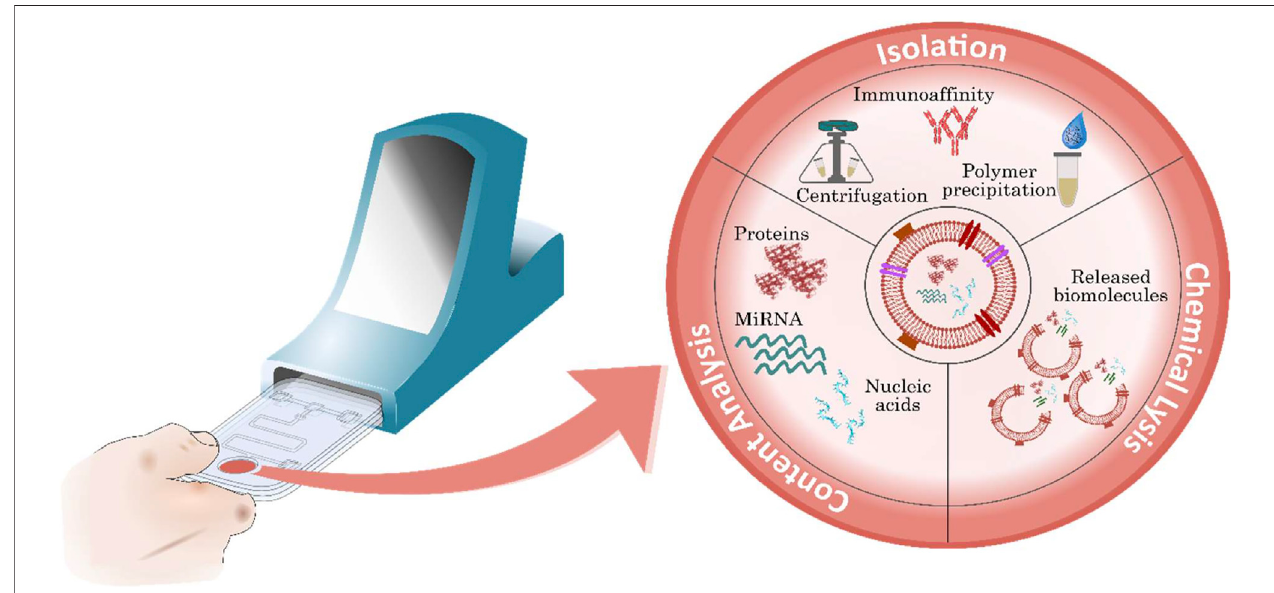
FIGURE 5 | Exosome-derived biomarkers for the diagnosis of CVD. Exosomes contain key potential biomarkers including various surface proteins, miRNAs and nucleic acids. Following isolation, exosomes can be measured, or further processed using exosome lysis before biomarker recognition to analyse contents.